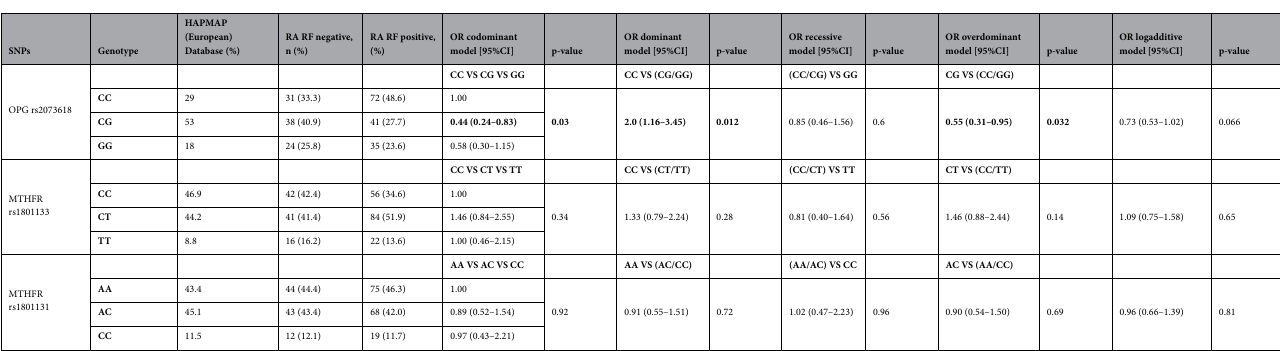
Table 4. Prevalence of the OPG rs2073618 and the MTHFR rs1801133 and rs1801131 SNP genotypes in RA RF negative and RF positive patients, adjusted by gender and age. Genotypes, OR and p-value for the five genetic models (codominant, dominant, recessive, overdominant and additive) were estimated with SNPstats software (statistically significant if p < 0.05). OPG osteoprotegerin, MTHFR methylene tetrahydrofolate reductase, OR odds ratio, SNP single nucleotide polymorphism, VS versus, RA rheumatoid arthritis, RF rheumatoid factor, HAPMAP haplotype map. Significant values are in